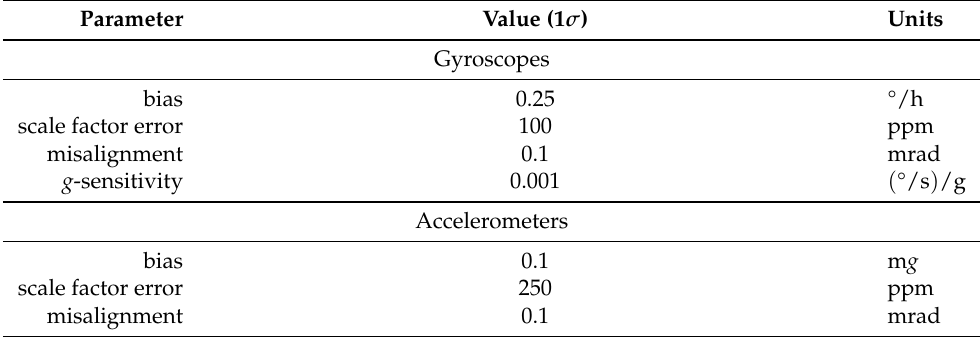
Table 3. Parameters of sensors used in